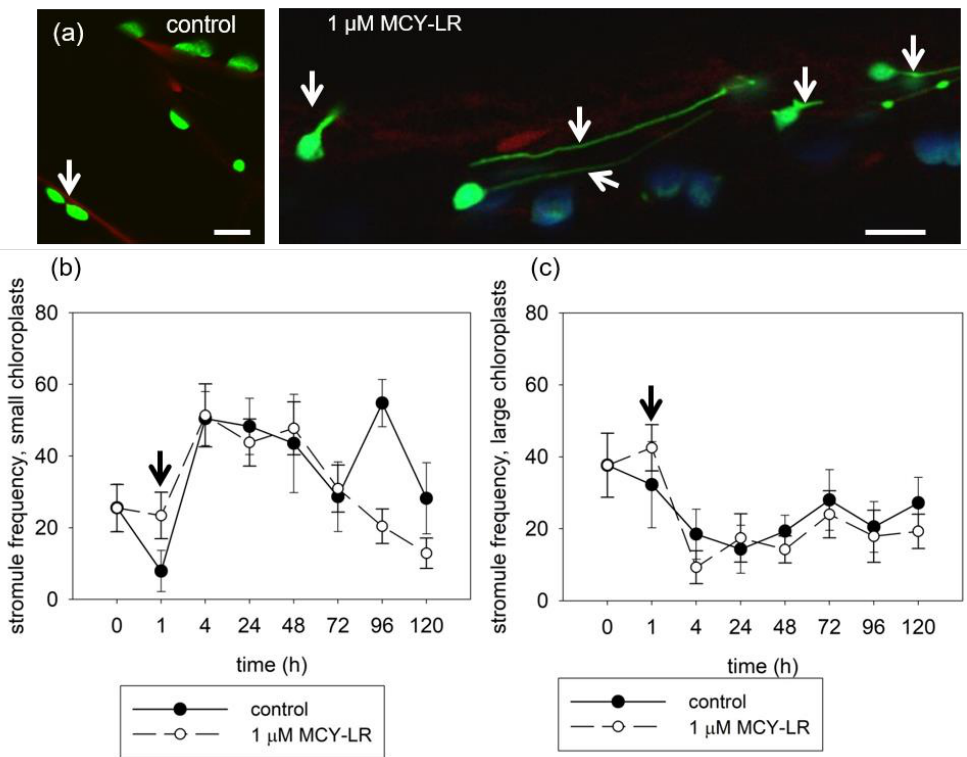
Figure 4. MCY-LR increases stromule frequency at a short term of exposure and decreases it at long exposures. ( a ) For small-sized chloroplasts in hypocotyls, 1 h of MCY-LR treatment of tpFNR:GFP plants shows a visible increase of stromule occurrence (arrows). Scalebar 10 µM. ( b , c ) Time-dependent effects of MCY-LR on stromule frequencies for small ( b ) and large ( c ) chloroplasts. Arrows show increases of stromule frequencies at 1 h MCY-LR exposures.